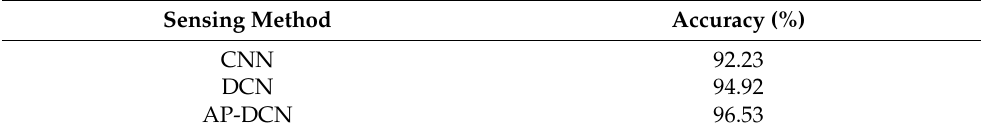
Figure 11. The confusion matrix of AP-DCN recognition accuracy. Table 2. Comparison of recognition accuracy of different methods.